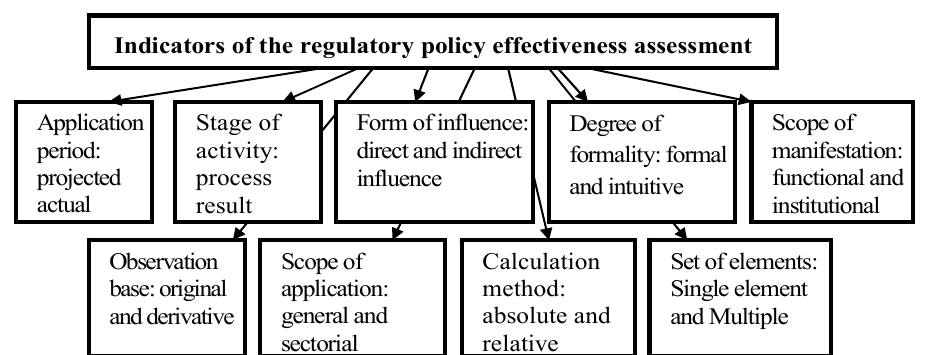
Fig. 2: Classification of the regulatory policy effectiveness assessment indicators